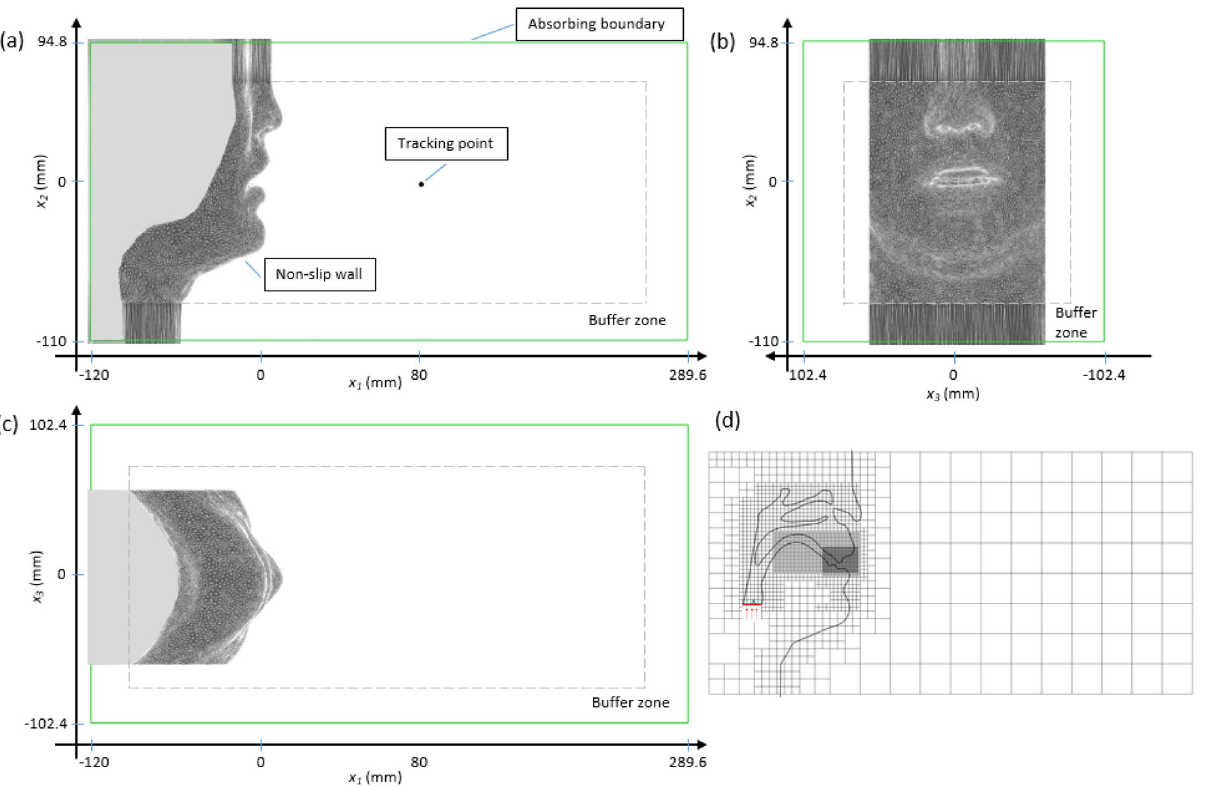
Figure 3. ( a )–( c ) The three-view diagram of overall computational domain. ( d ) grid distribution (every 16th gridline is shown for